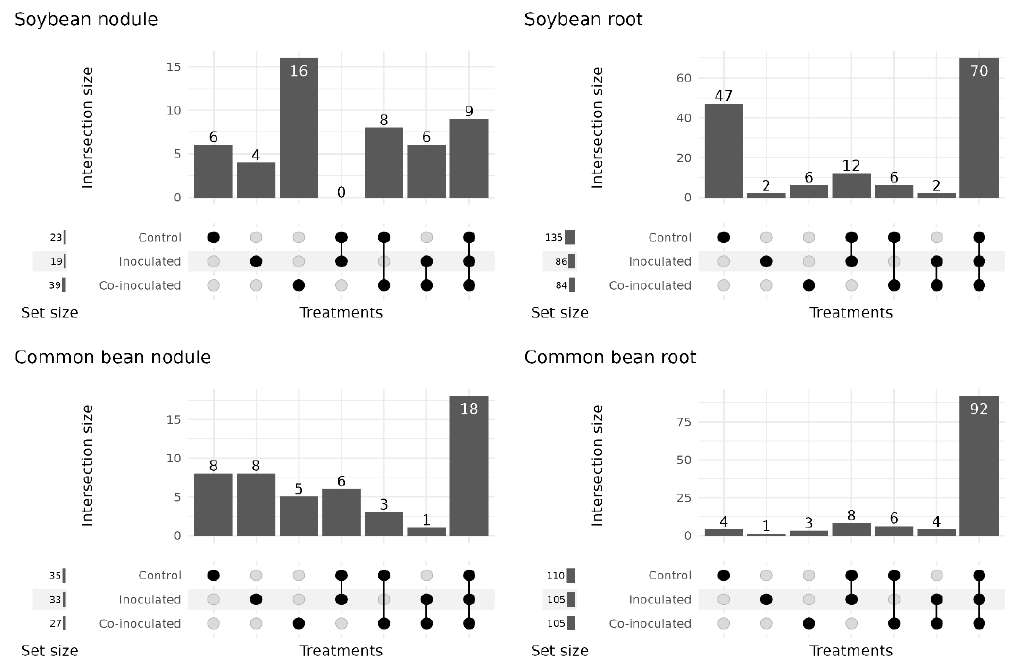
Figure 2. The number of genera found in the microbiomes of soybean and common bean nodules and roots in the treatments (i) non-inoculated (control); (ii) inoculated with the specific rhizobia; (iii) co-inoculated with the specific rhizobia and Azospirillum brasilense .